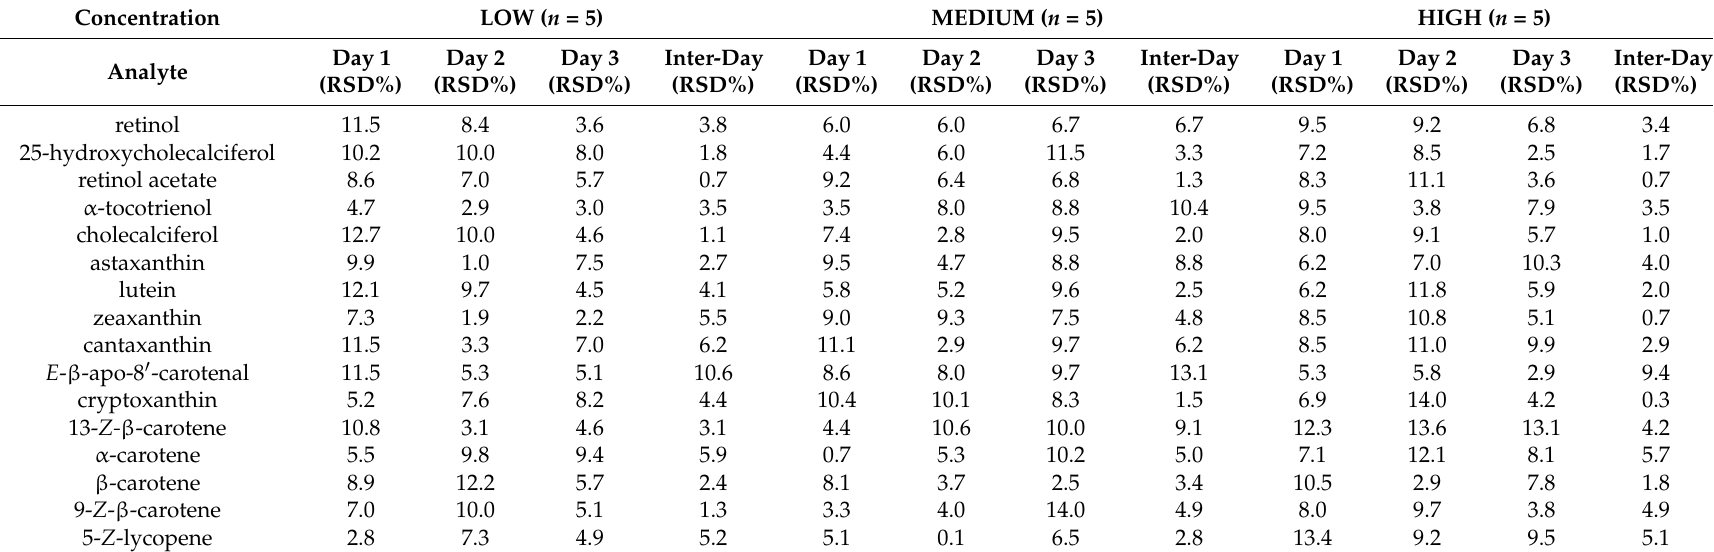
Table 4. Intra- and inter-day precision obtained in samples by the HPLC-MS/MS